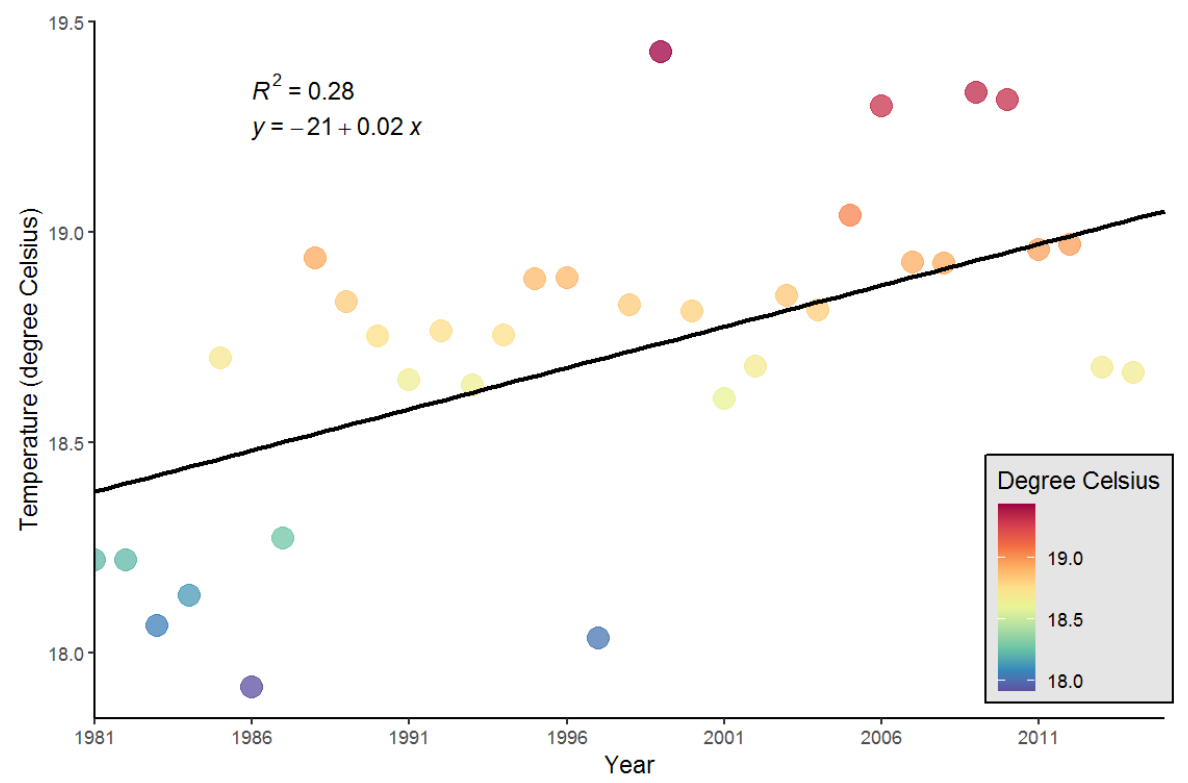
Figure 9. Trend of annual mean temperature in the study area.